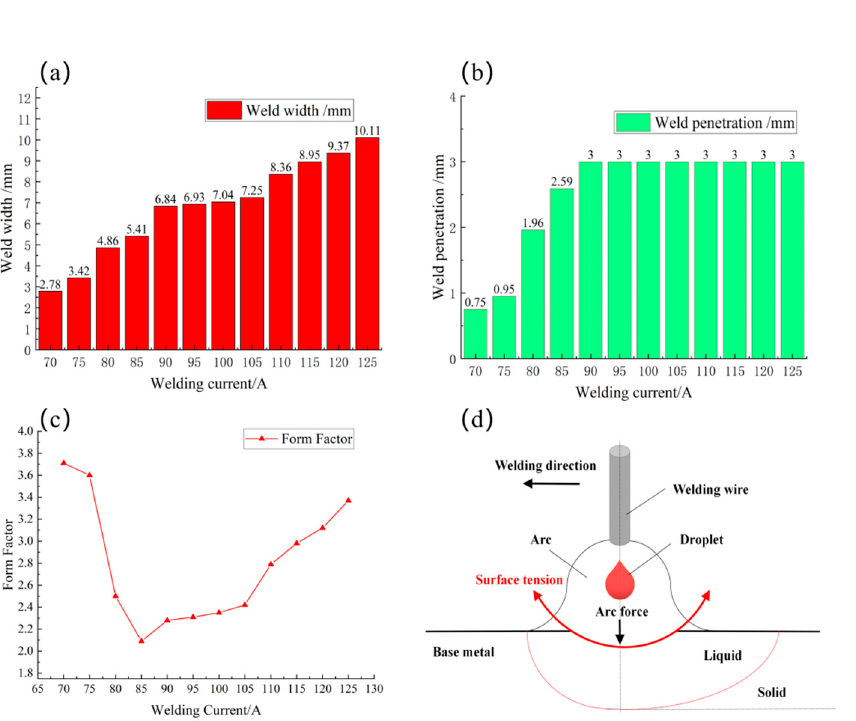
Figure 4. Variation under different heat inputs: ( a ) fusion width; ( b ) weld penetration; ( c ) weld appearance factor; ( d ) macrodiagram of melt pool force.